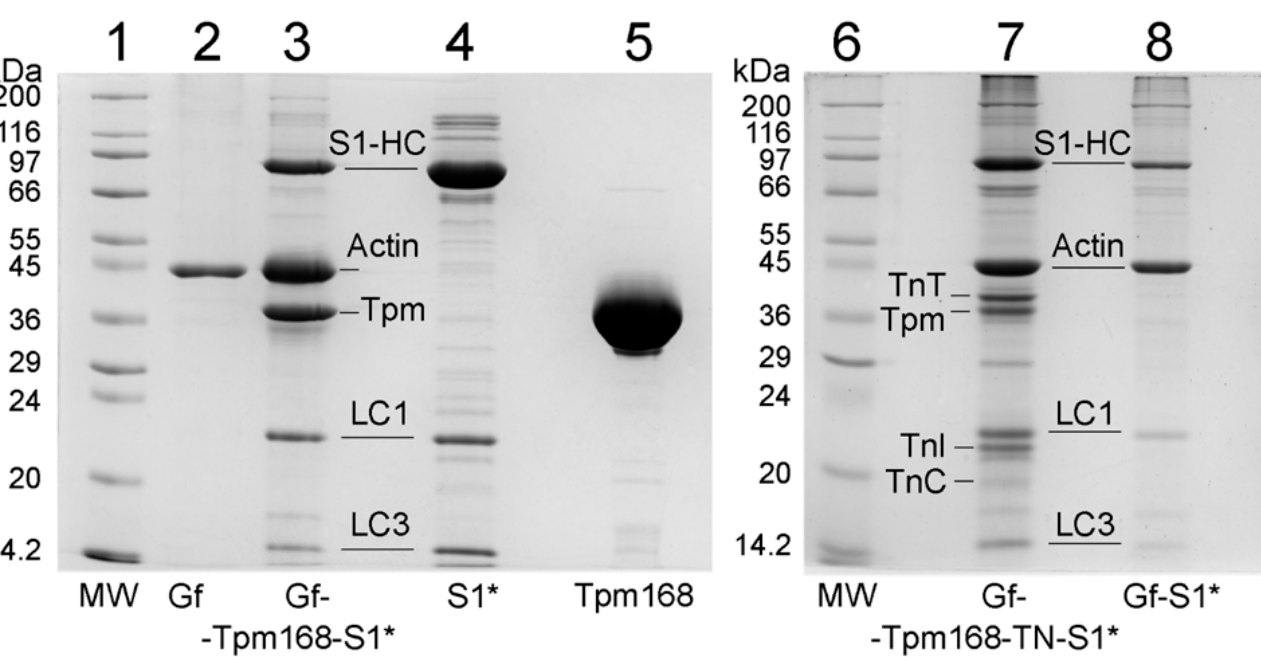
Figure 1. Control of protein purity and muscle fiber composition. Proteins: S1-AEDANS, lane 4; R168HTpm (Tpm168), lane 5. Muscle fibers: ghost fibers, lane 2; ghost fibers containing S1-AEDANS, lane 8; ghost fibers with thin filaments reconstructed by the R168H-mutant tropomyosin and containing S1-AEDANS in the absence of troponin, lane 3, and in the presence of troponin (TN), lane 7. Unbound proteins were removed by exposing the fibers to the washing solution for 15 min. Here, 6–8 fibers were used to prepare a probe loaded into a gel. As calculated using ImageLab 6.0, ghost fibers (lane 2) were composed of F-actin by 93.6%. The ratio of the R168H-mutant Tpm bound to actin was as high as for the Tpm control [10].